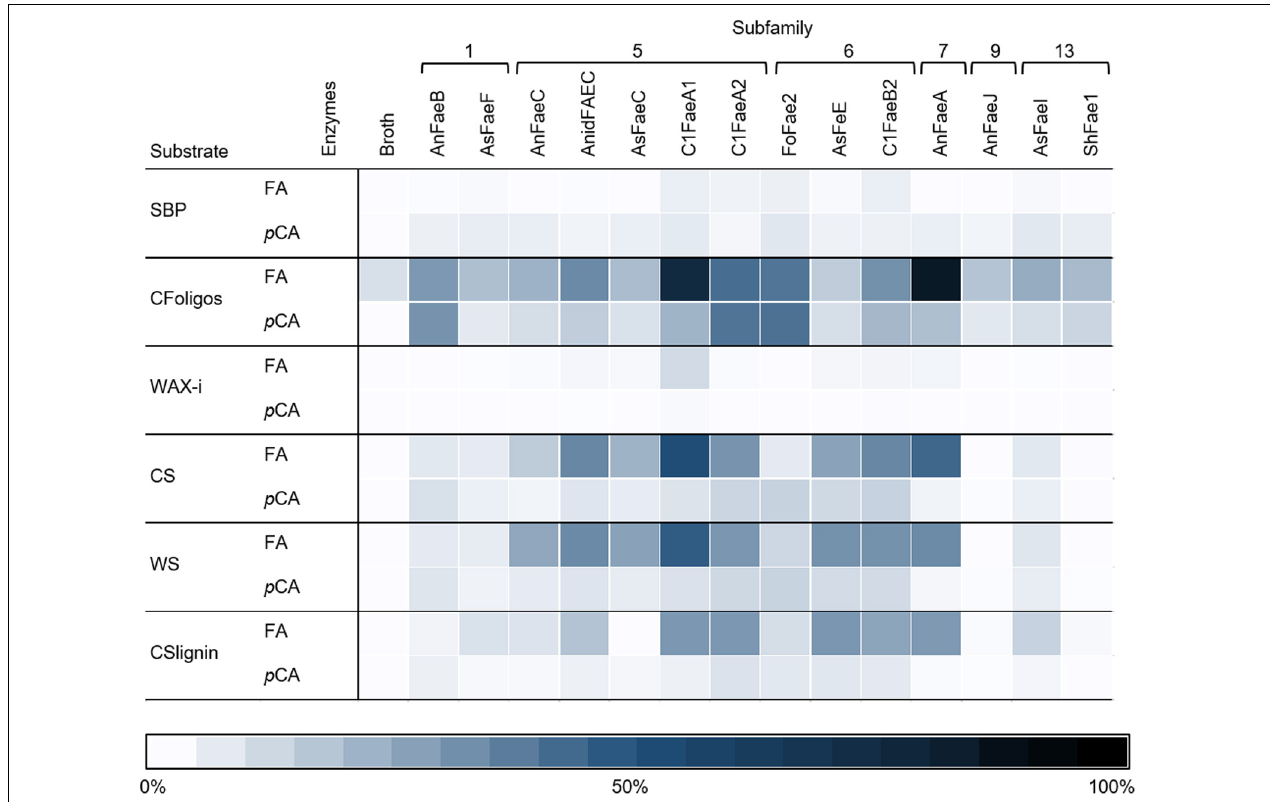
FIGURE 4 | The heatmap shows the specificity of FAEs (representing 6 SFs) toward six substrates. Corn fiber oligomers (CFoligo), corn stover (CS), corn stover lignin isolate (CSlignin), sugar beet pectin (SBP), insoluble wheat arabinoxylans (WAX-i), and wheat straw (WS) were incubated with FAEs and without (broth) at 37 ◦ C for 19 h and the release of FA and pCA was measured by RP-UHPLC-UV ( n = 2). The release of FA and pCA from the substrates by the FAEs are given as percentages of the total amount of ester bound FA and pCA that have been determined by saponification (0.5 M KOH). The broth is the culture supernatant of P. pastoris which was grown without FAE insertion (negative